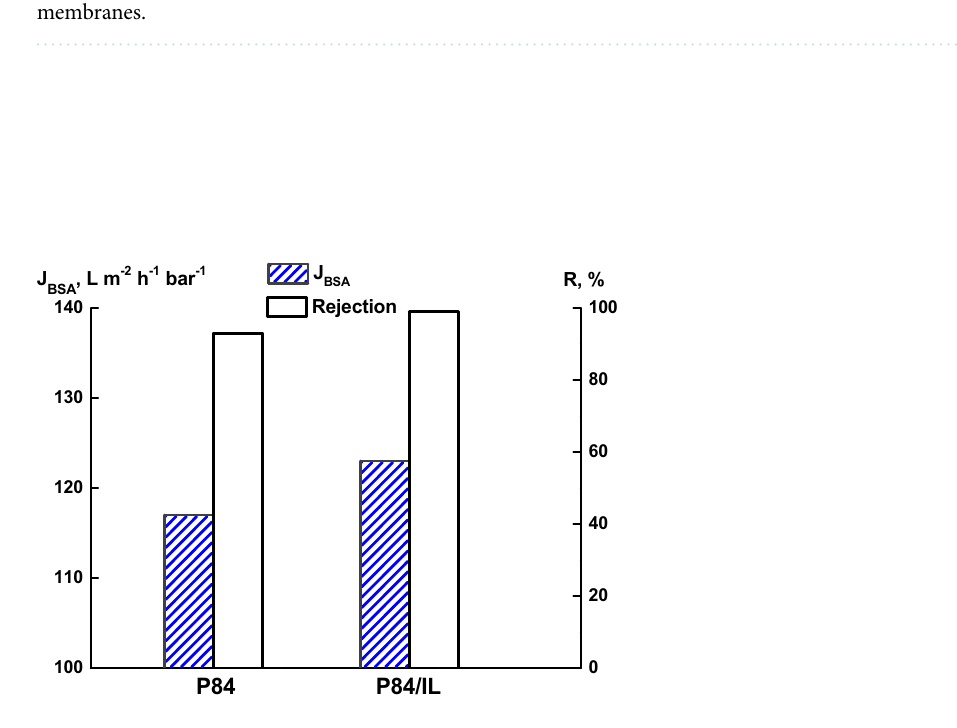
Figure 8. The flux of aqueous solution of BSA ( J BS A ) and the BSA rejection ( R ) for the P84 and P84/IL